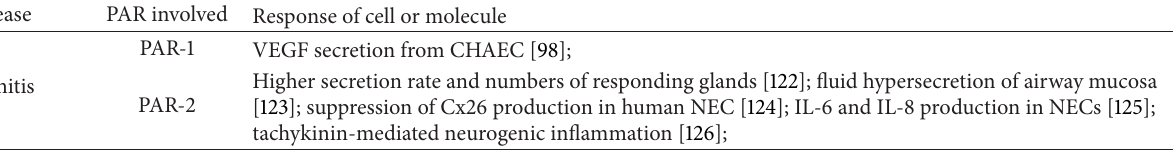
Table 4: Roles of PARs in allergic